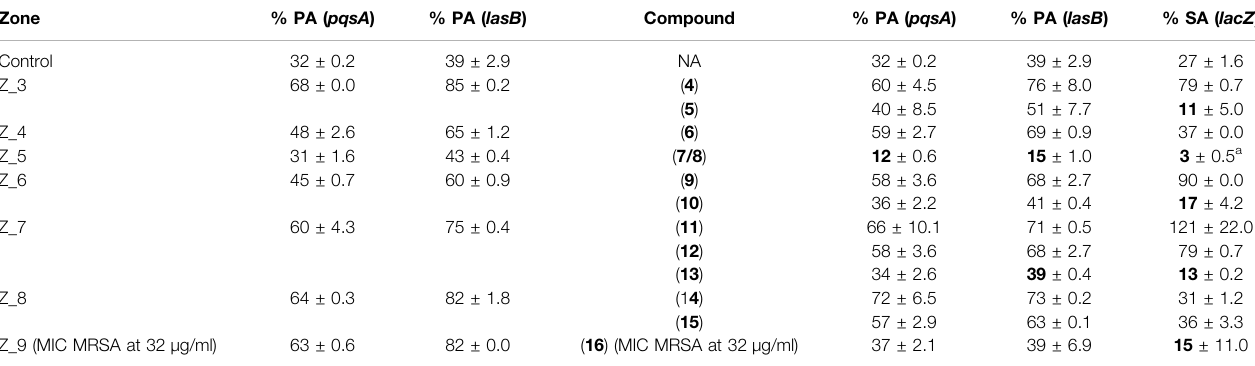
TABLE6| Minimuminhibitoryconcentration(MIC)andquorumsensinginhibition(QS)assaysofzonesoffractionsandtheircorrespondingcompoundscomparedtoseveral positive controls.